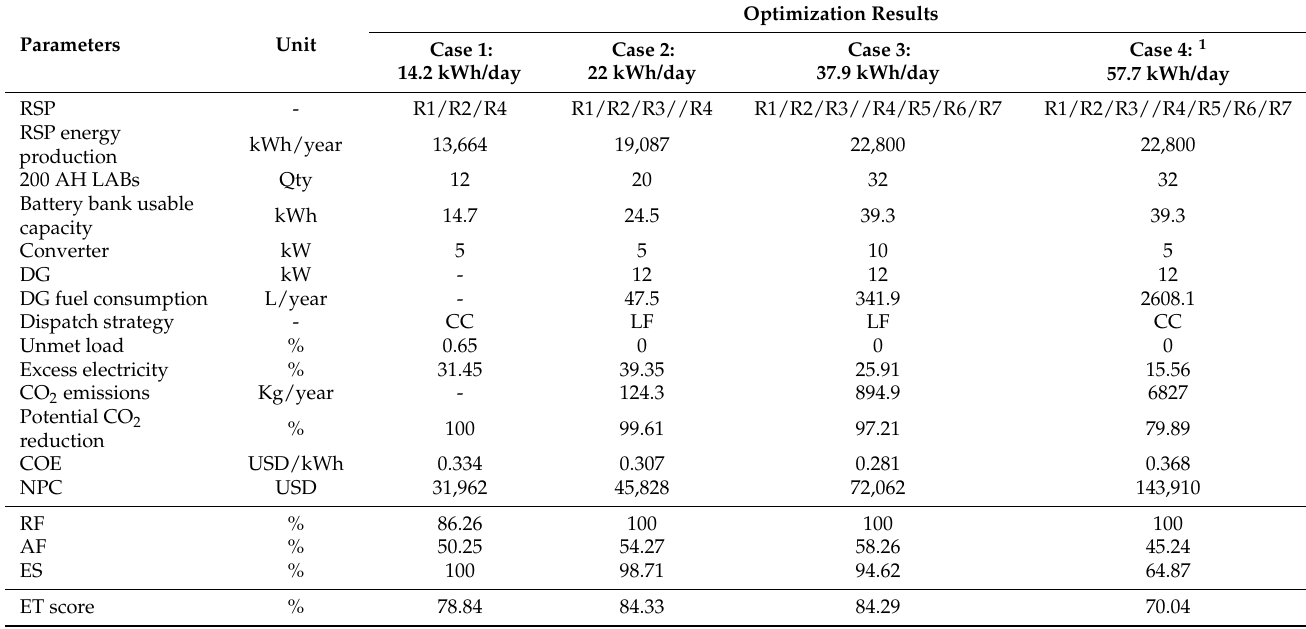
Table 12. Comparison of the final OSC at four case